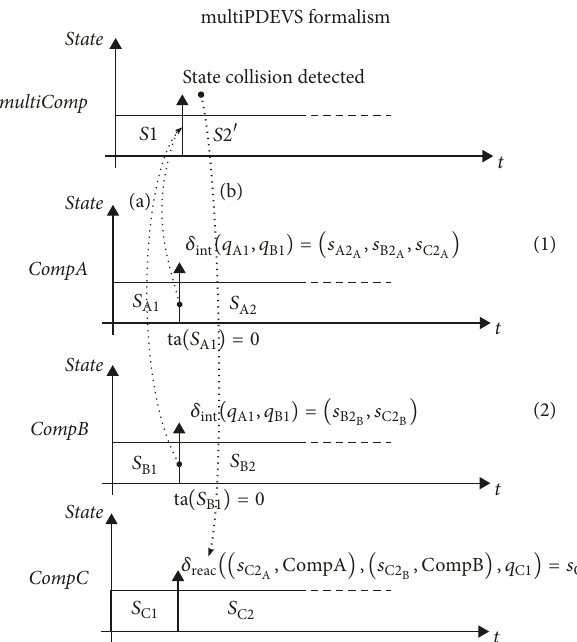
Figure 3: Illustration of state collision management using